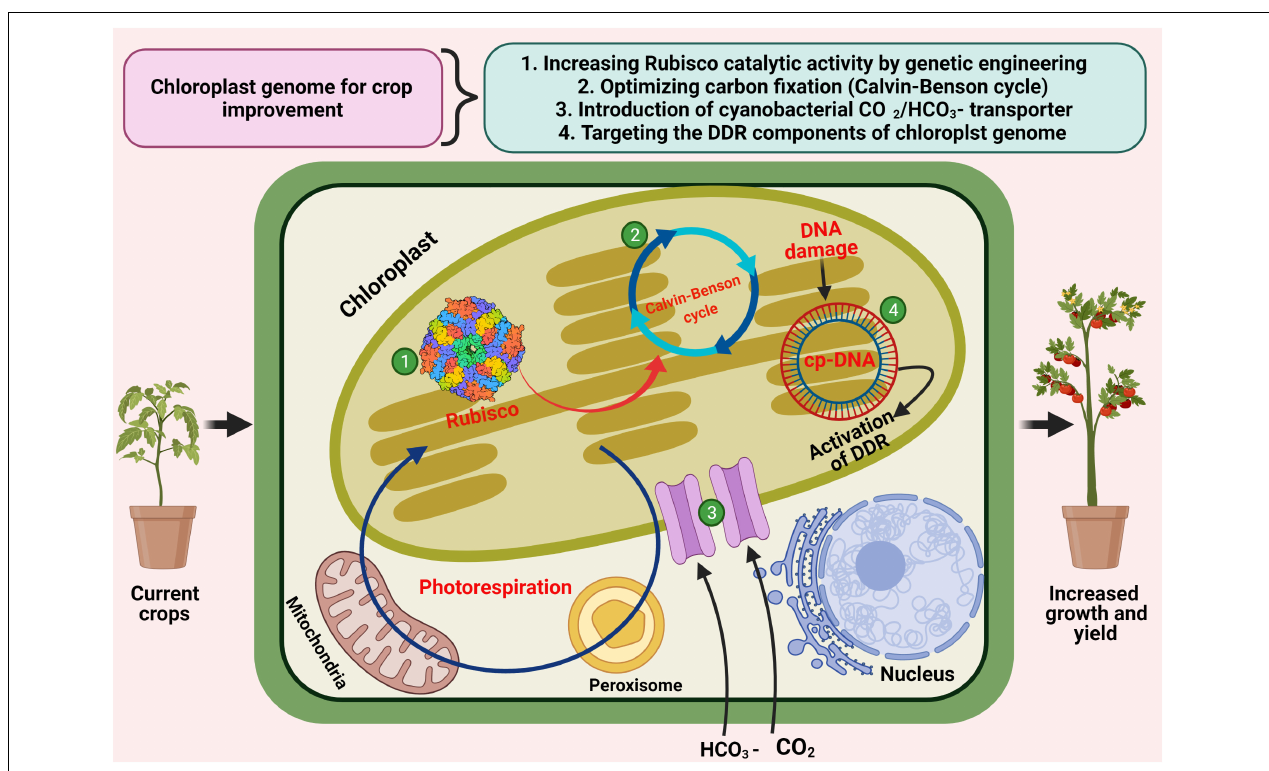
FIGURE 5 | Modulation of chloroplast genome for crop improvement. Various aspects of employment of chloroplast genome for improving photosynthesis and crop productivity including modifications of Rubisco subunits through plastome engineering, optimization of carbon fixation, the introduction of cyanobacterial HCO 3 – and CO 2 transporters, and targeting various components of DNA damage response